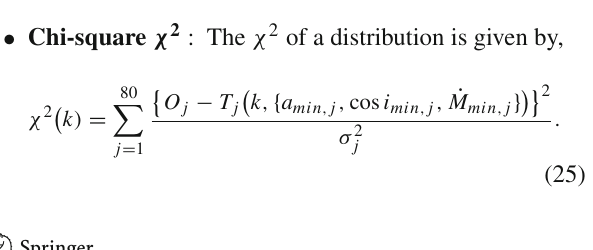
Fig. 1 The figure above depicts the variation of the theoretical lumi- nosity from the accretion disk with frequency considering two sets of black hole masses, namely, M = 10 9 M (cid:13) and M = 10 7 M (cid:13) . The inclination angle is taken to be i = cos − 1 0 . 8 while the accretion rate assumed is 1 M (cid:13) year − 1 . The black, blue and red lines correspond to